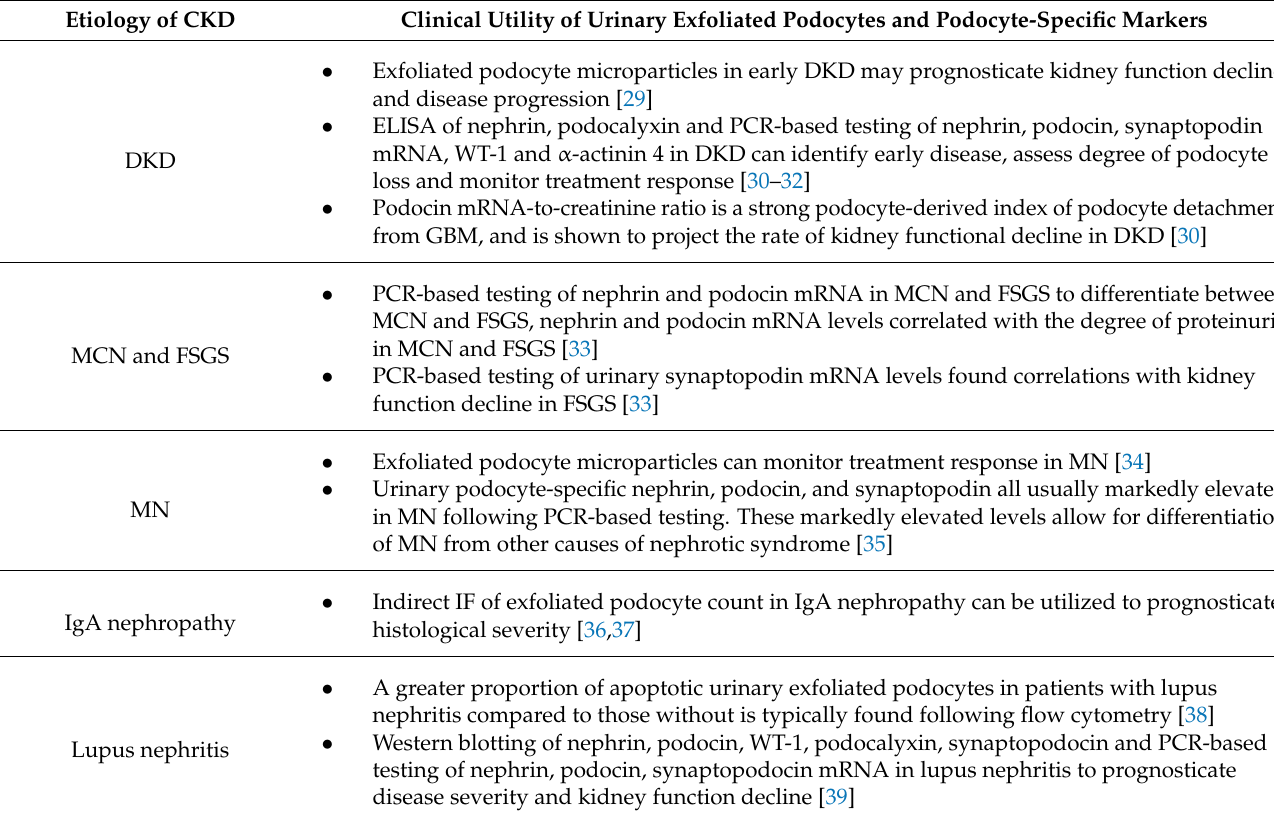
Table 1. Clinical utility of urinary exfoliated podocytes and podocyte-specific markers for early diagnosis and prognostication of